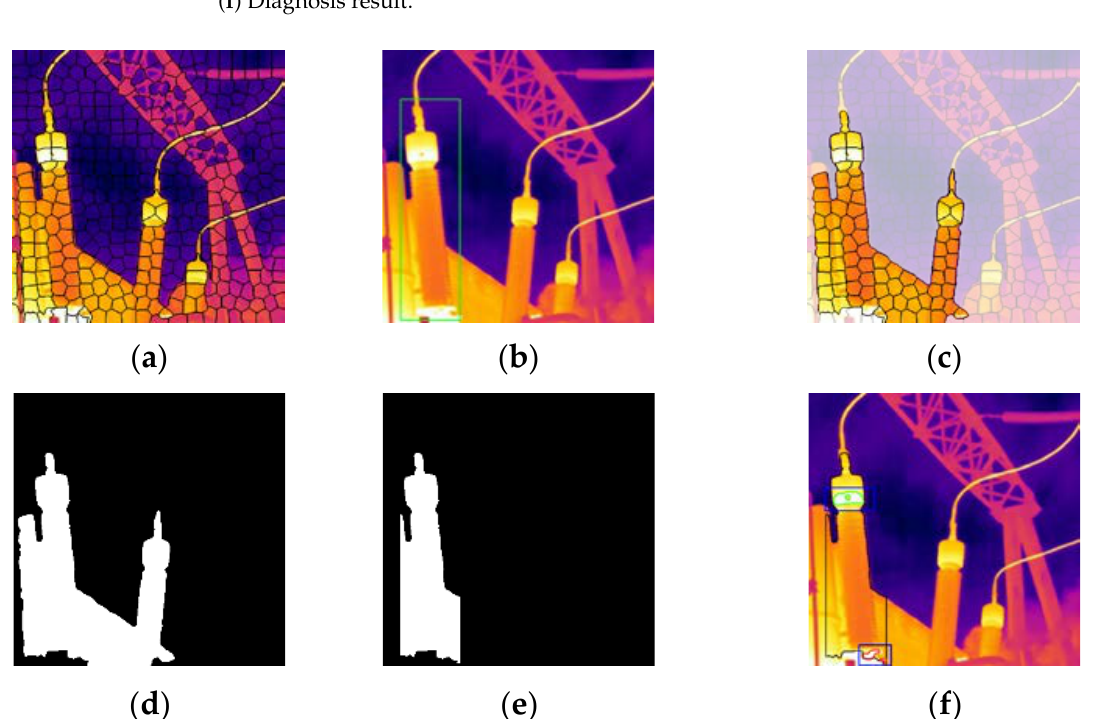
Figure 8. The results of each step in the process of diagnosis by Keys’ method ( a ) Super pixel segmentation ( b ) Image recognition ( c ) Super pixel binning ( d ) Image segmentation ( e ) Area to be inspected ( f ) Diagnosis result.